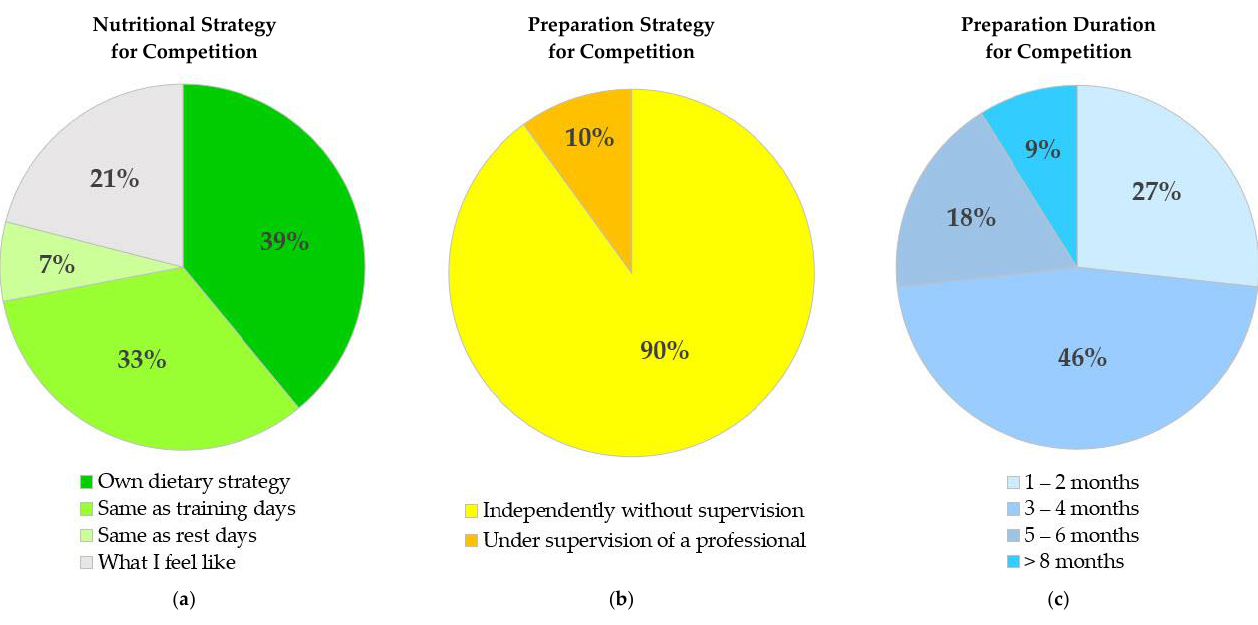
Figure 3. Pie charts demonstrating general strategies that endurance runners reported to prepare themselves for running competitions: ( a ) the prevalence of general nutritional strategies for running competitions based on four categories, with “own dietary strategy” as the most prevalent strategy; ( b ) the prevalence of general preparation strategies for running competitions based on two categories, with “independently without supervision” as the most prevalent strategy; ( c ) the prevalence of different durations for preparation of runners for running competitions based on four categories, with “ 3 – 4 months” as the most prevalent strategy.